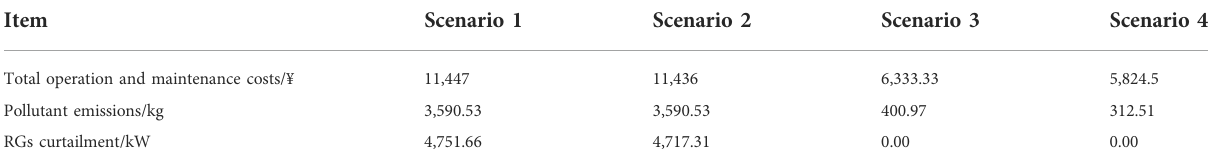
TABLE 1 Economic items under different